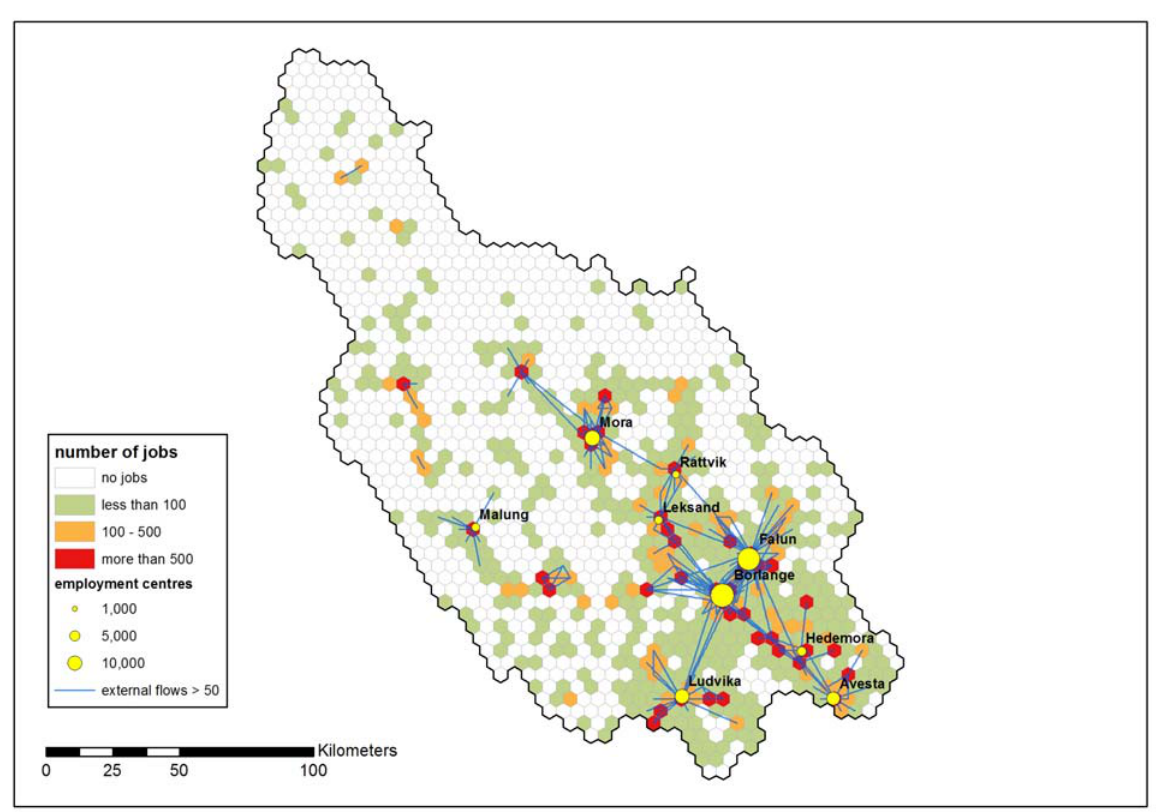
Figure 2. Number of jobs and major employment centers and external